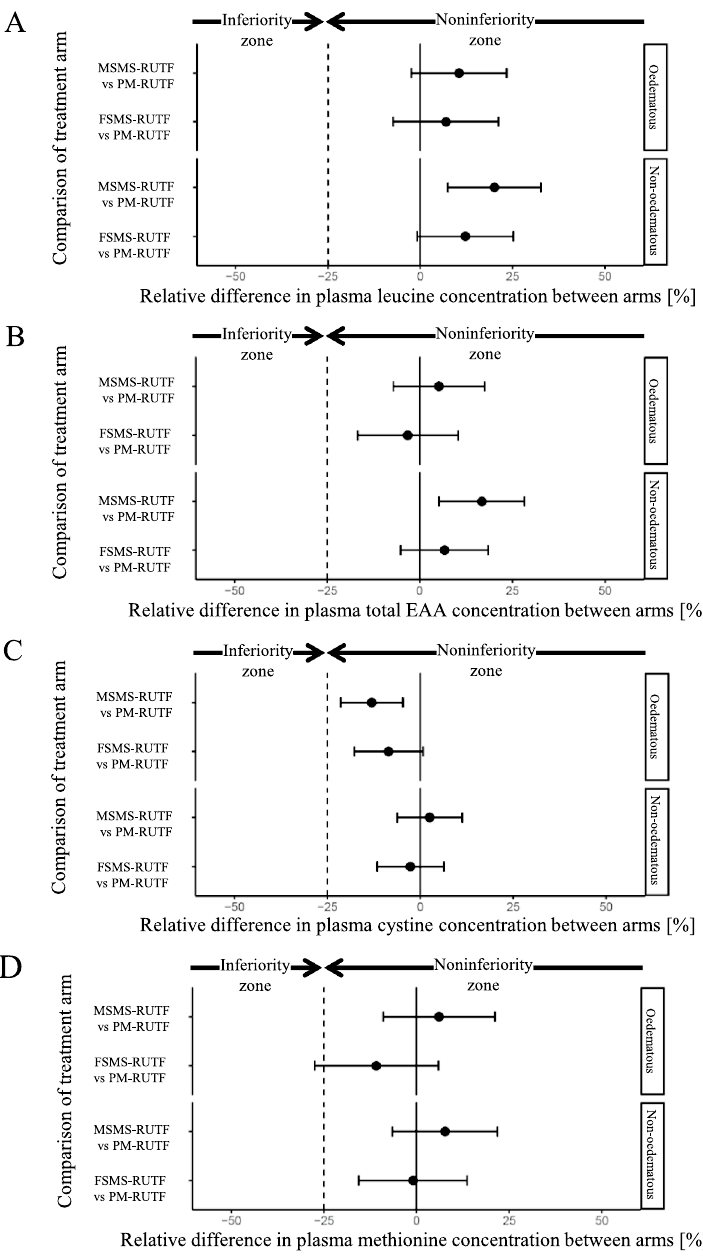
Figure 1. Comparison of the difference in plasma amino acid concentrations at discharge between the FSMS-RUTF arm and PM-RUTF arm and between the MSMS-RUTF arm and PM-RUTF arm by using the data from each SAM subgroup . The differences are shown as the relative value based on the plasma amino acid concentration of the PM-RUTF arm at discharge; 0% for the x-axis indicates the mean concentration of the PM-RUTF arm at discharge; 95% CIs were estimated by simultaneous inference procedures in the mixed model. The filled circle and error bar indicate a point estimate of the difference and 95% CI. The dotted line shows the noninferiority margin (− 25%). All specimens described as “Analysis” in Fig. 2 were used for this analysis. (A) Relative difference in plasma leucine concentration between arms. (B) Relative difference in plasma total EAA concentration between arms. (C) Relative difference in plasma cystine concentration between arms. (D) Relative difference in plasma methionine concentration between